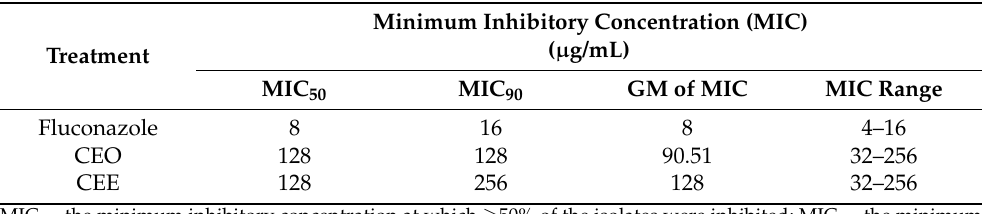
Table 4. MIC 50 , MIC 90 , GM of MIC, and MIC range of fluconazole, Coleus amboinicus essential oil (CEO), and C. amboinicus ethanolic extracts (CEE) against planktonic cells of Microsporum canis. Minimum Inhibitory Concentration (MIC) ( µ g/mL) Treatment MIC 50 MIC 90 GM of MIC MIC Range Fluconazole CEO MIC 50 , the minimum inhibitory concentration at which ≥ 50% of the isolates were inhibited; MIC 90 , the minimum inhibitory concentration at which ≥ 90% of the isolates were inhibited; GM: geometric mean.